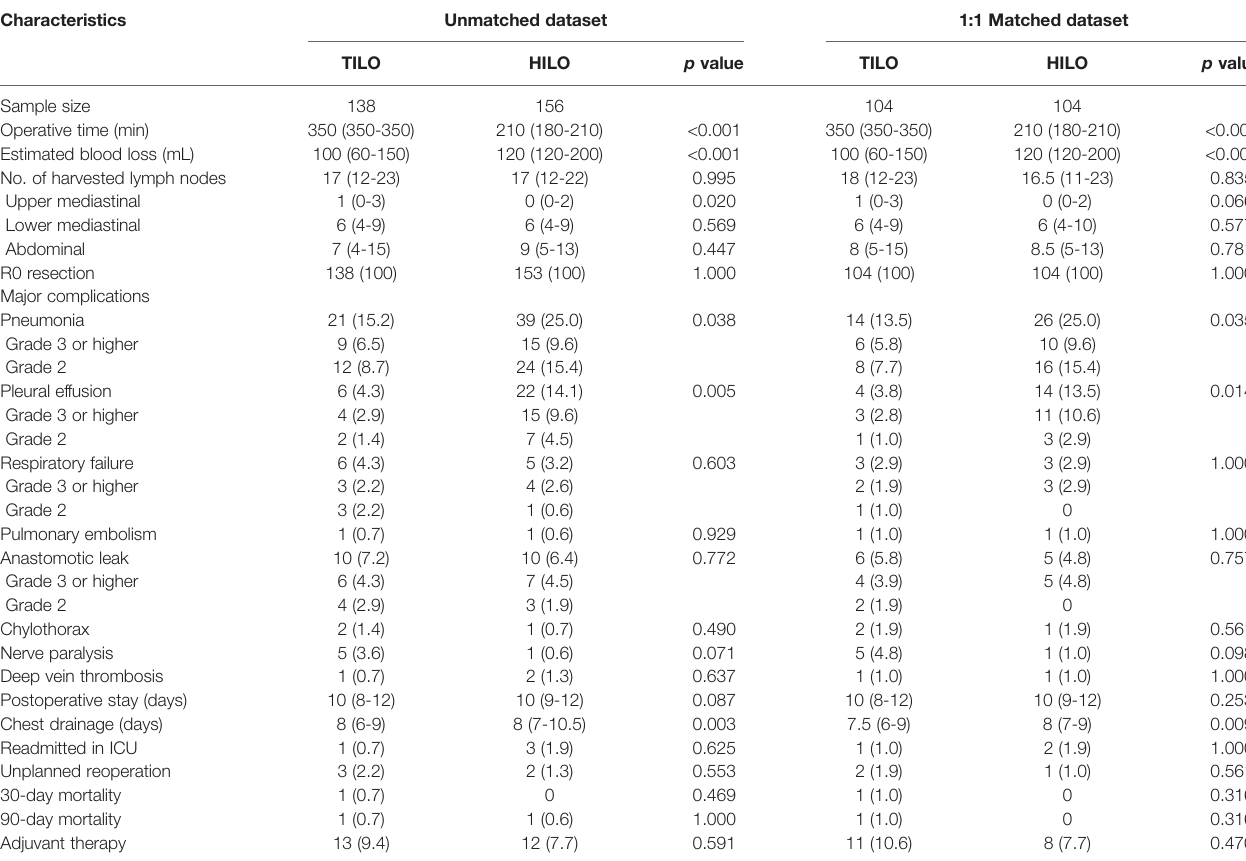
TABLE 2 | Intraoperative and postoperative outcomes of patients with TILO versus HILO. Characteristics